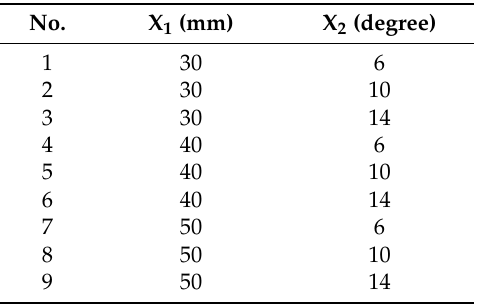
Table 1. Values assigned to the variables and their